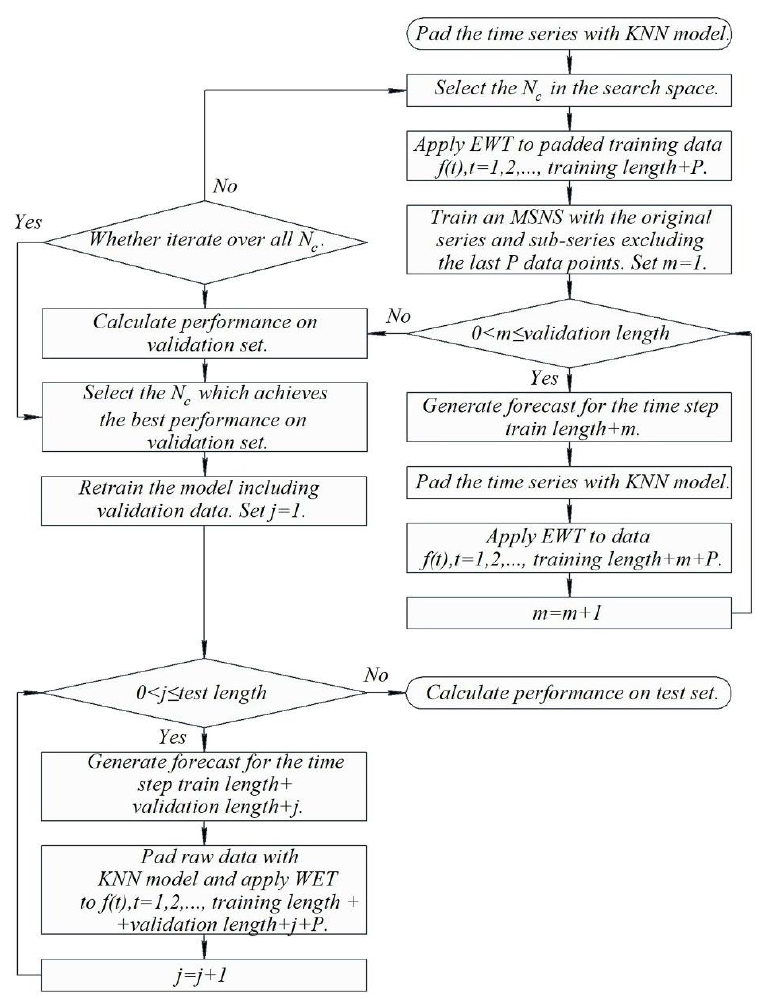
Figure 1. Flowchart of the proposed